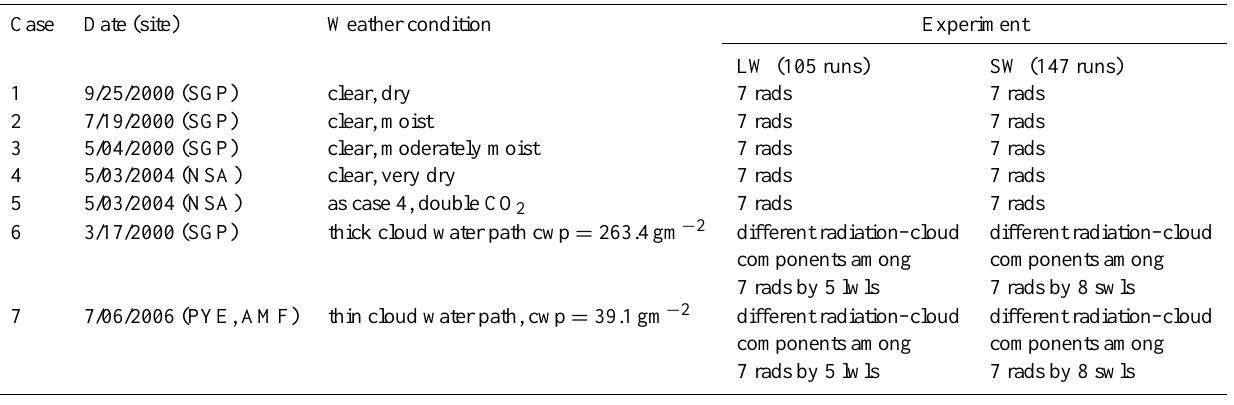
Table 1. The CIRC Phase I cases and experiment design for CAR radiative transfer